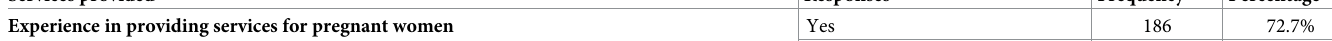
Table 3. Number and percentage of the questions on the services provided regarding self-care by the community pharmacists in pregnancy and lactation (n = 256). Services provided